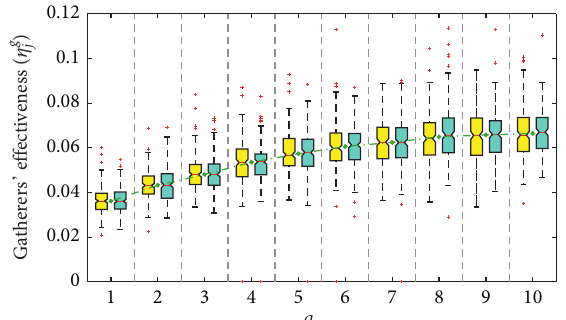
Figure 10: Fairness of the HGMP for gatherer agents for each value . The results demonstrate that the workload is still dis- of q max tributed equally on both gatherers when q